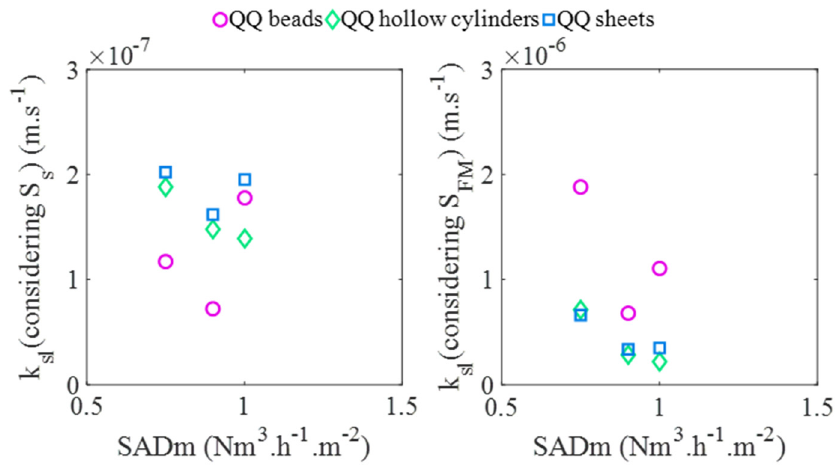
Figure 9. Mass transfer coefficients under different air flowrates and for the three shapes of media particles. ALMBR experiments.